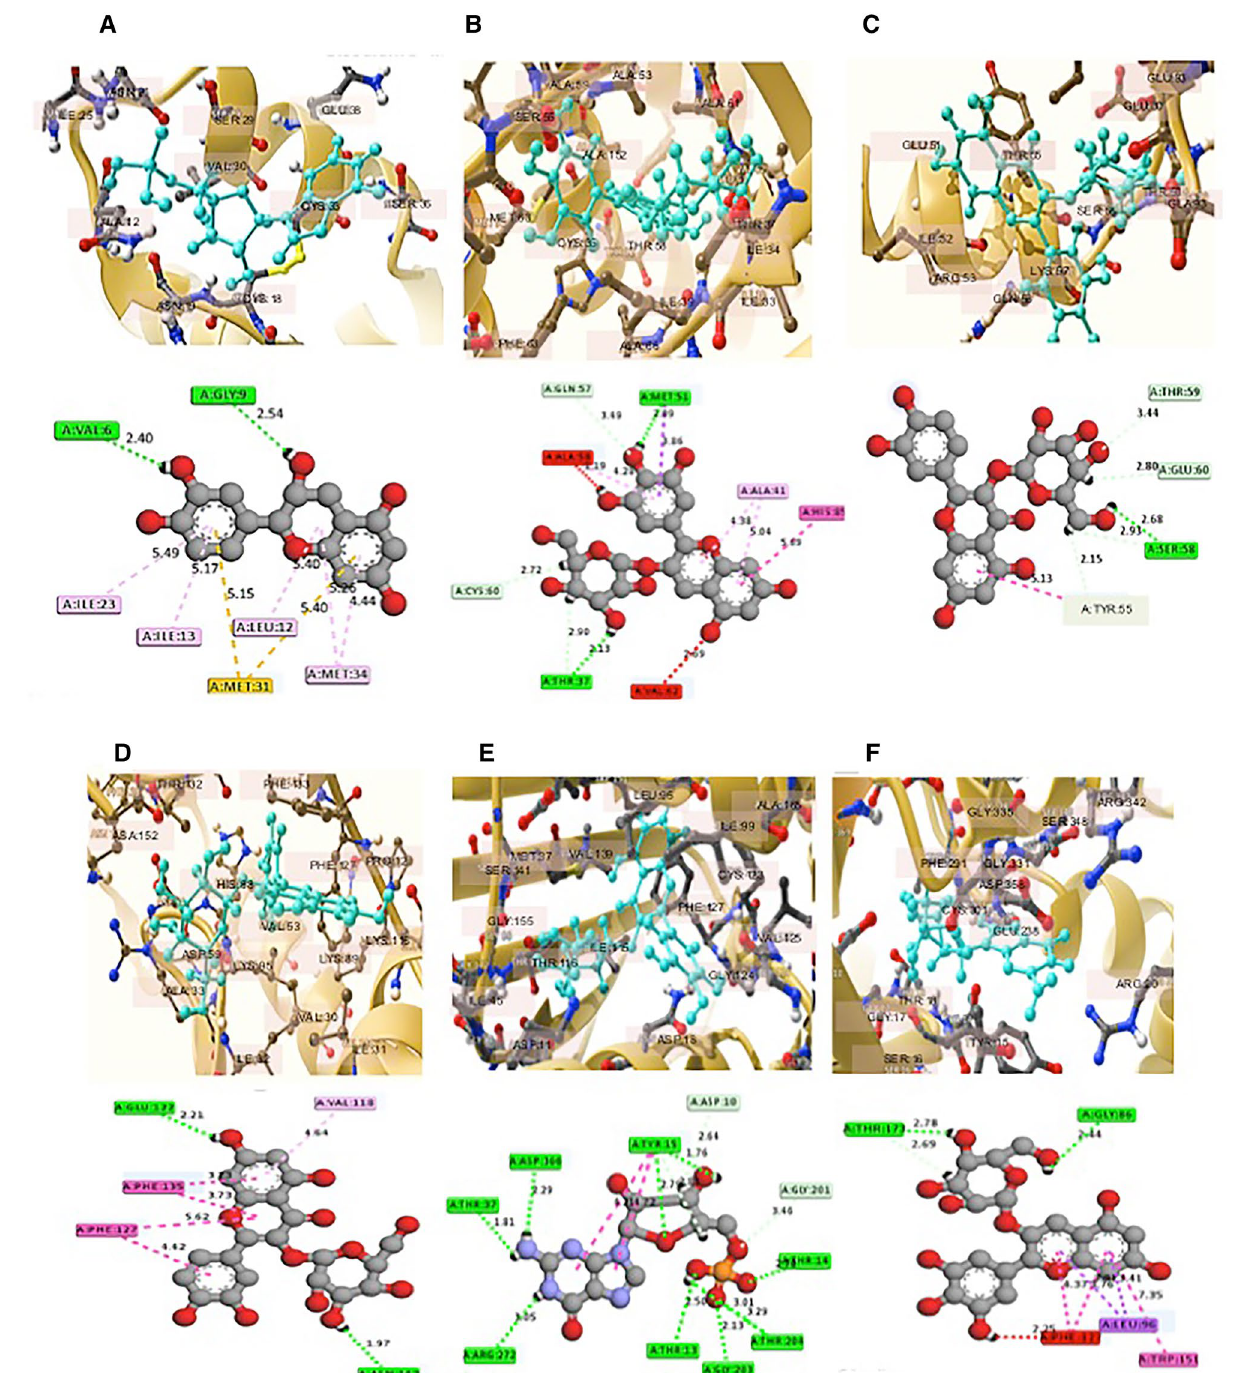
Figure 4. The 2D and 3D diagrams of acetylcolenestraea with Disodium 5’-inosinate ( A ), elongation factors with delphinine 3-glucoside ( B ), histone subunit3 with hyperoside ( C ), arginine kinase with hyperoside ( D ), HSP70 with disodium 5-guanylate ( E ), HSP90 with Delphinine 3-glucoside ( F ) virulence insect proteins. Molecular docking was built uisng SAMSON software